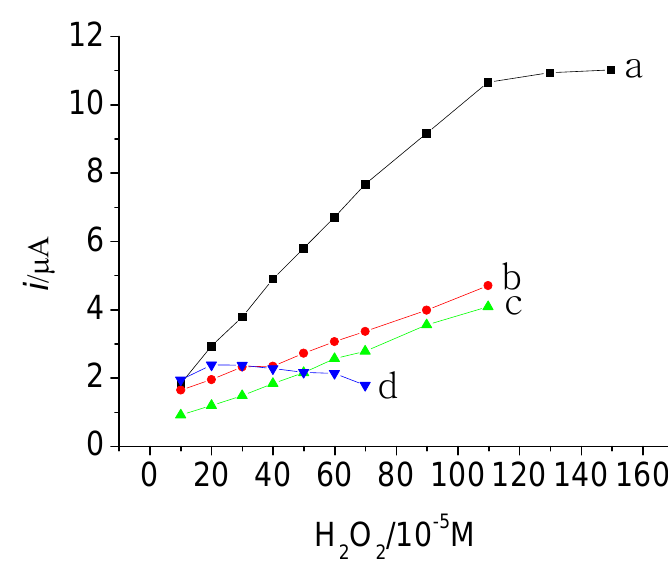
Figure 4 . Effect of the chitosan concentration and glyoxal on the biosensor response studied by O in 10.0 mL 0.02 M pH 7.0 PBS. The chitosan film was prepared calibration plots for H 2 2 with a solution: (a) 1% chitosan with 0.025% glyoxal; (b) 0.5% chitosan with 0.025% glyoxal; (c) 0.25% chitosan with 0.025% glyoxal and (d) 1% chitosan without